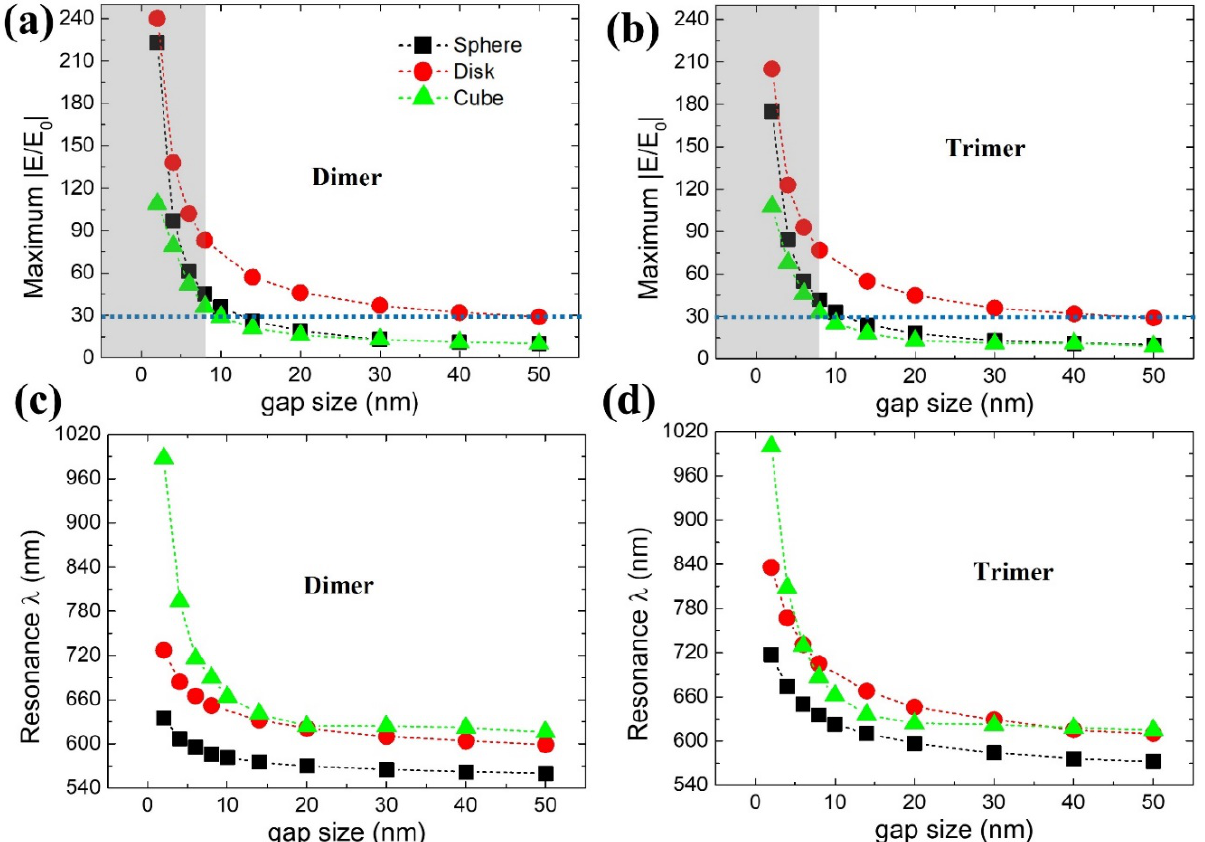
Figure 2. Maximum near-field strength |E/E 0 | obtained from dimer ( a ) and trimer ( b ) plasmonic nanostructures for different NP shapes (sphere, disk, and cube) from its respective resonance wavelength positions ( c ) and ( d ), respectively. These data are extracted from simulated broadband |E/E 0 | spectra as seen from SM Figures S2 and S3. Grey color region within blue dotted lines indicates our region of interest on the basis of gap mode enhancement.